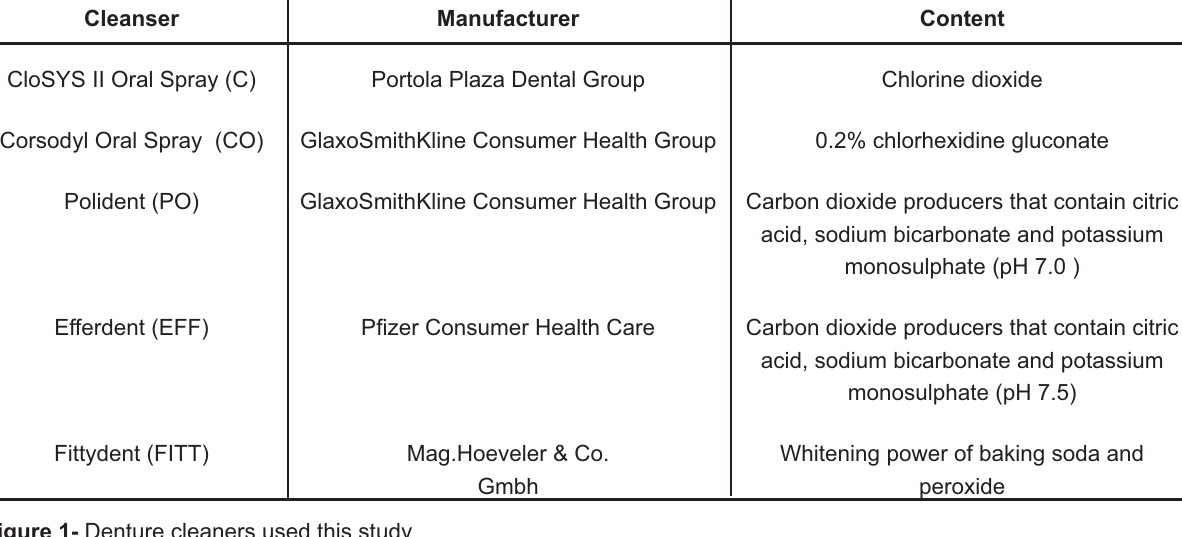
Figure 1- Denture cleaners used this study